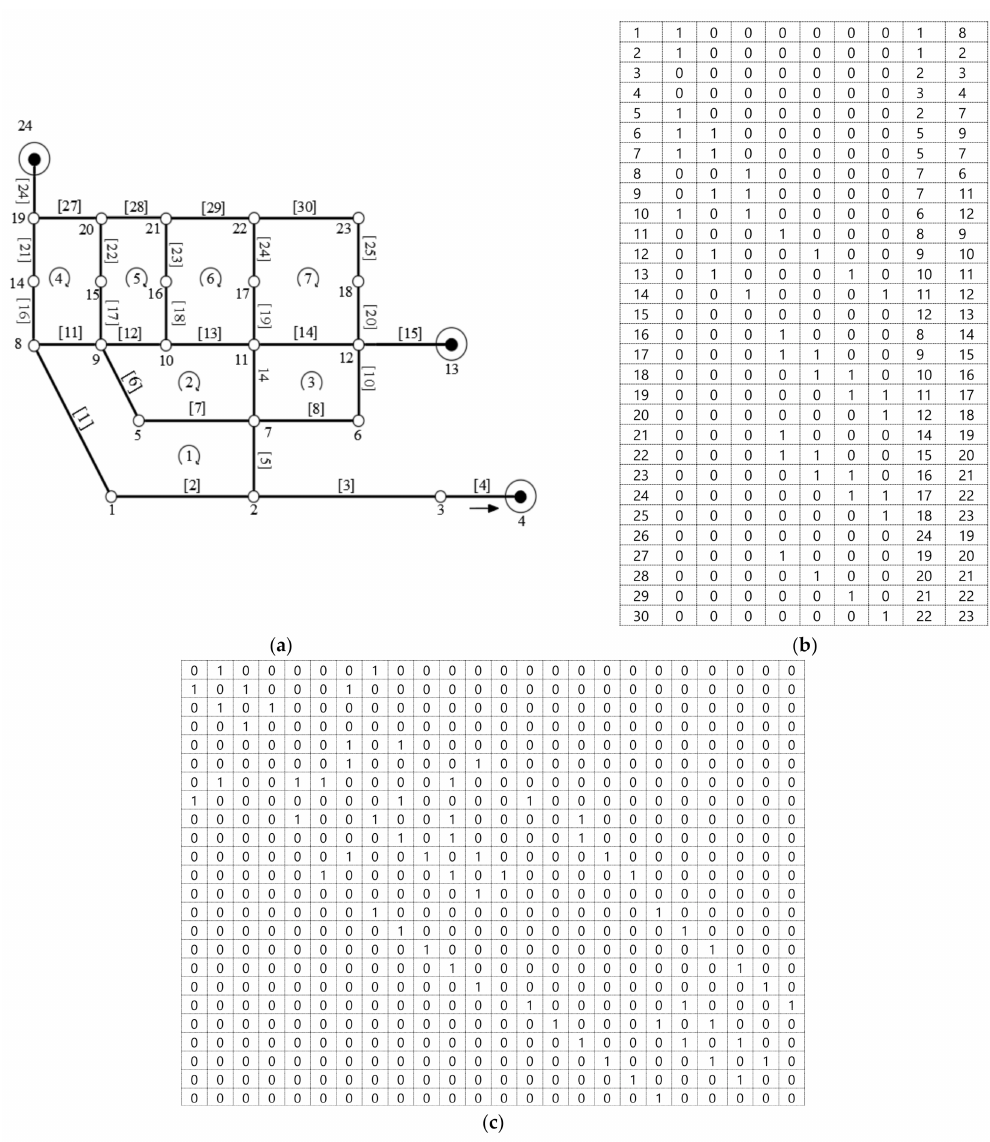
Figure 2. Mathematical representation of a base graph: ( a ) example base graph; ( b ) B-Matrix; ( c )